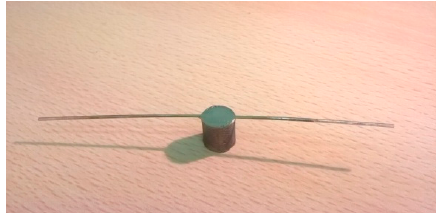
Figure 1. Picture of the POF-SPR sensing platform.